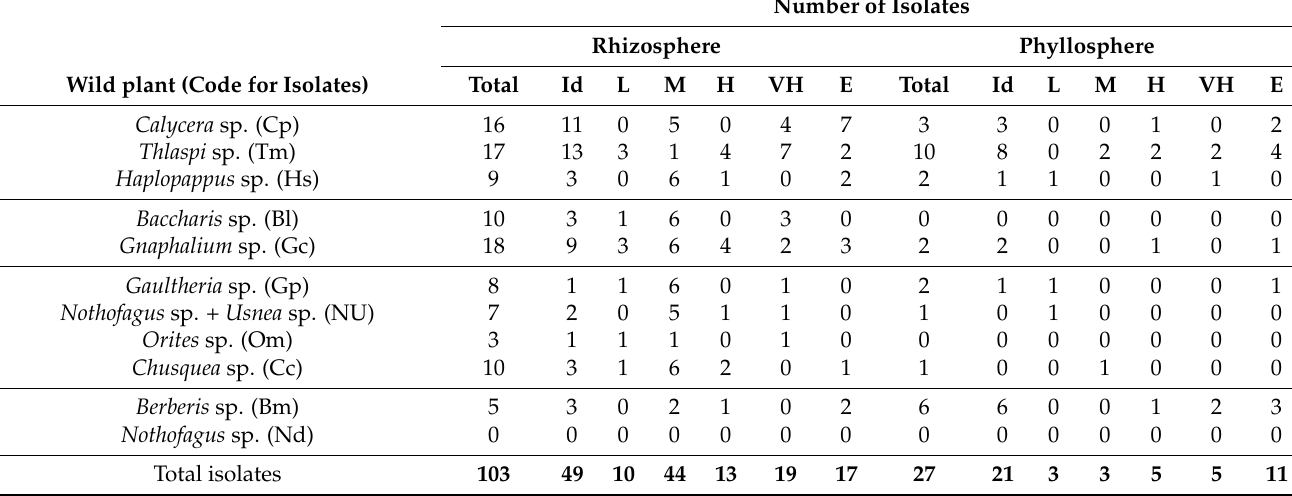
Table 2. Number of bacterial isolates from wild plants. Number of Isolates Rhizosphere Phyllosphere Wild plant (Code for Isolates)